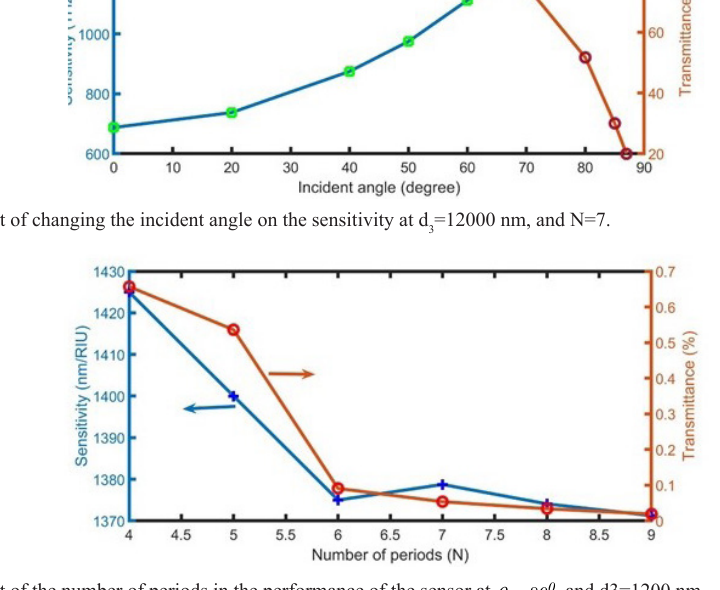
Figure 7. The effect of the number of periods in the performance of the sensor at 0 80 θ= and d3=1200